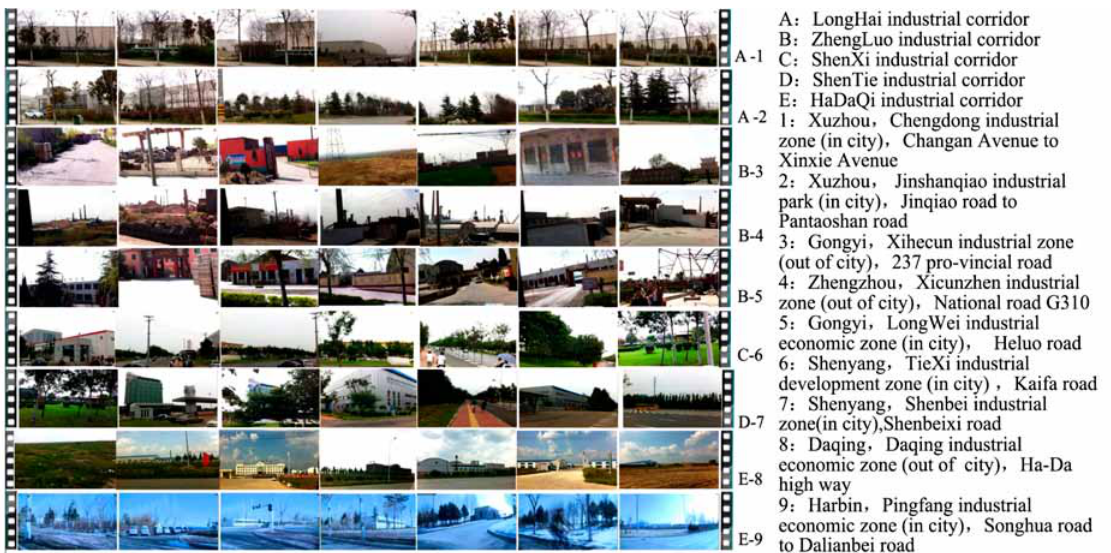
Fig. 2. Typical characteristics of the main sampling road of the industrial zones in the five industrial